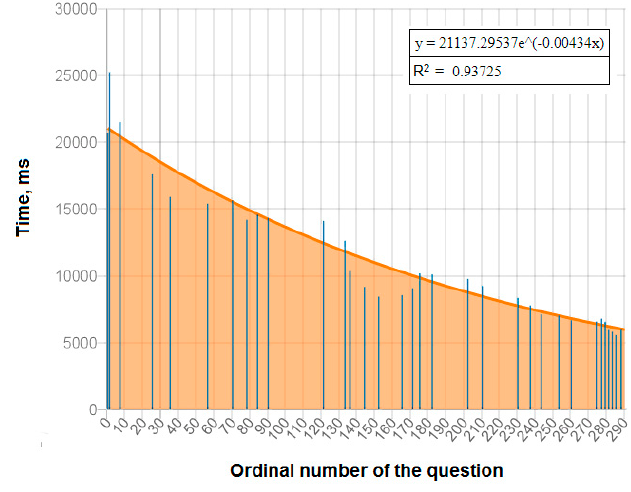
Figure 6. Exponential regression model.